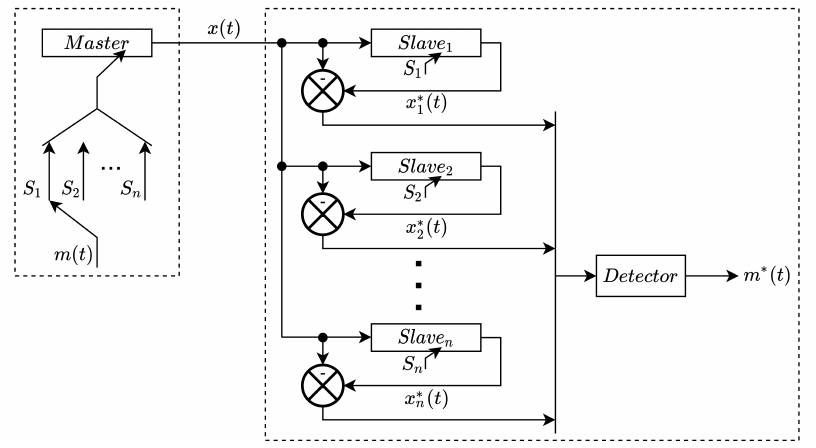
Figure 2. Block-diagram of the peer-to-peer SCM communication system with alphabet of n symbols.